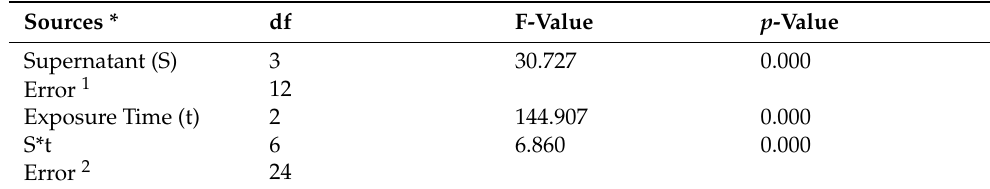
Table 7. Repeated measures analysis of variance parameters for the main effects and associated interactions for mortality rates of the larvae of Cydia pomonella in contact efficacy bioassay of cell-fee supernatants of symbiotic bacteria.